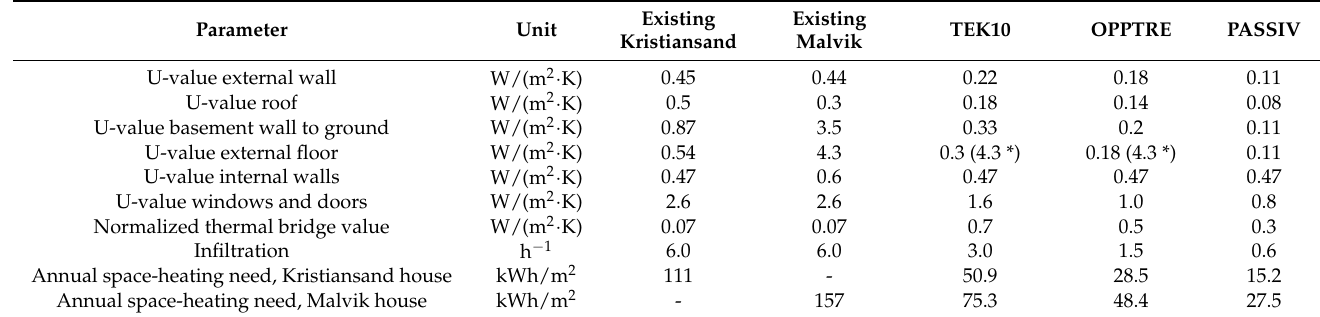
Table 2. Thermal properties for the two case houses for the different building envelope performance and the simulated space-heating needs using standard input